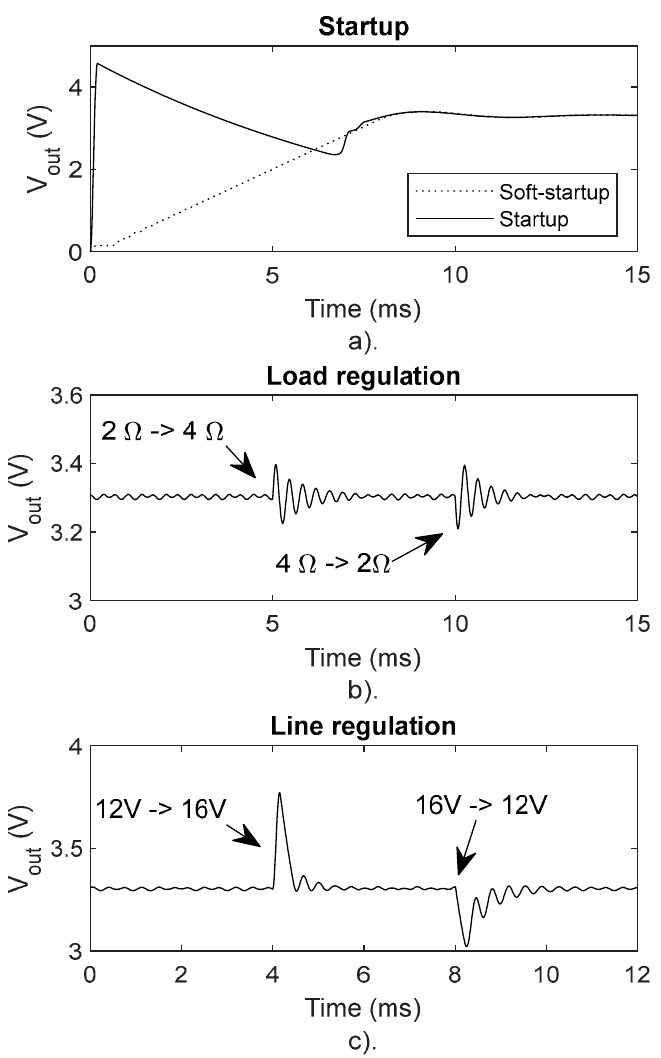
Figure 8. Simulation results: ( a ) power stage startup with/without soft-startup; ( b ) load regulation analysis; ( c ) line regulation analysis.